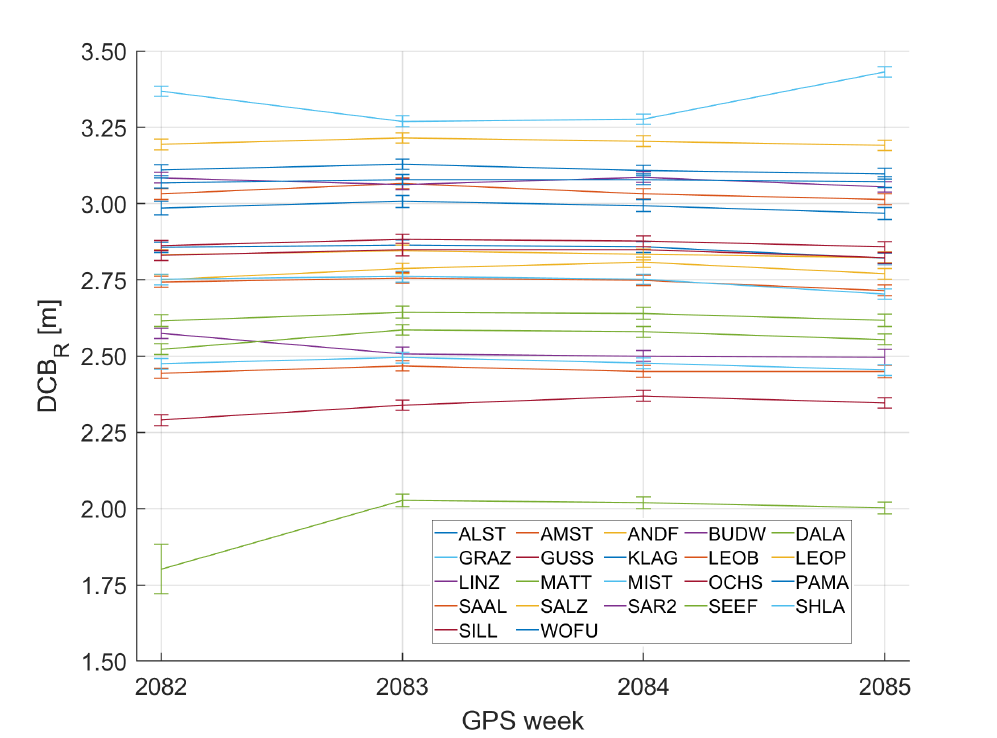
Figure 2. Station DCB values DCB R of the Regiomontan station network over four consecutive GNSS weeks in December 2019. The DCB R values mostly vary only a few centimeters during this period. The error bars indicate the standard deviation of the least squares